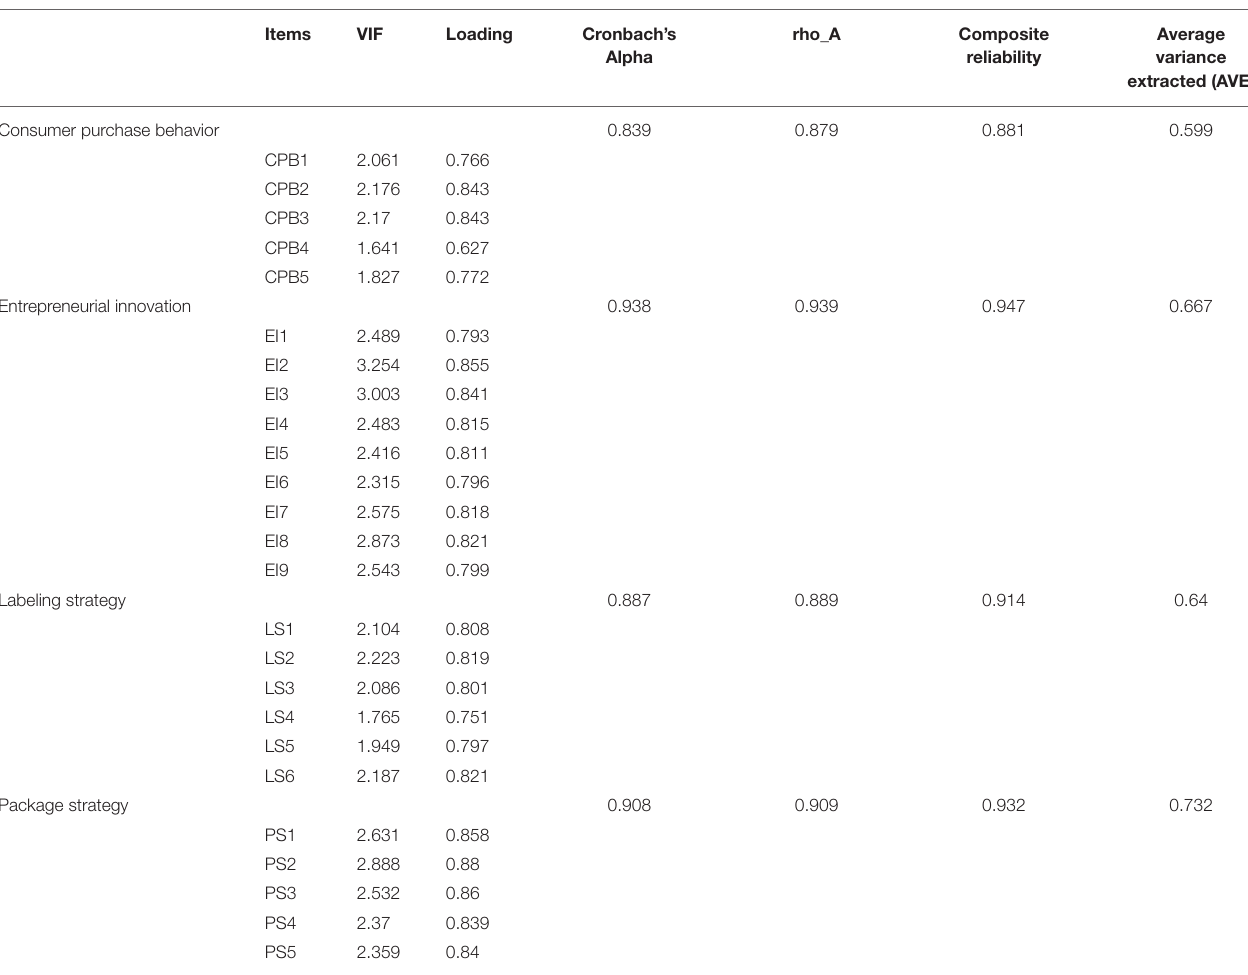
TABLE 1 | Factors loading, CR, AVE, and Alpha values. Weights